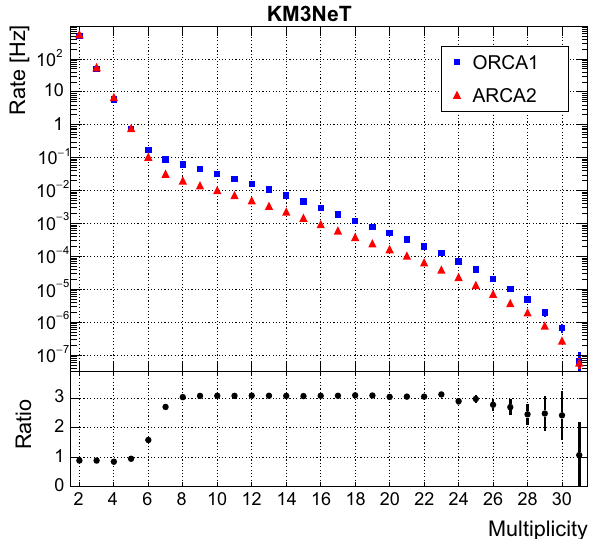
Fig. 5 Top: coincidence rates as a function of the multiplicity for the ORCA1 and ARCA2 detectors averaged over all the DOMs of each detector.Bottom:ratiobetweenORCA1andARCA2coincidencerates. Up to a multiplicity of six, the coincidence rate is dominated by 40 K decays. Above a multiplicity of seven, atmospheric muons dominate. Only statistical errors are shown